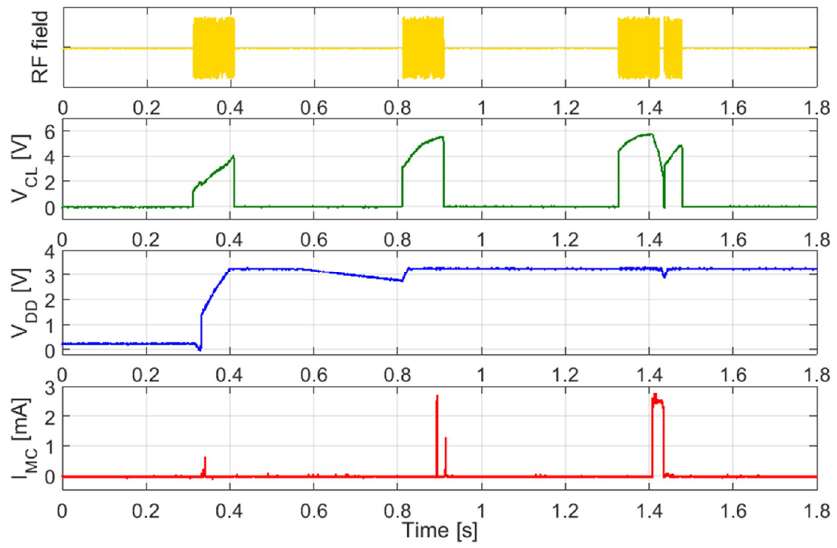
Figure 6. V CL , V DD , I MC signals and RF field correspondent to the startup of sequential measurement cycles.